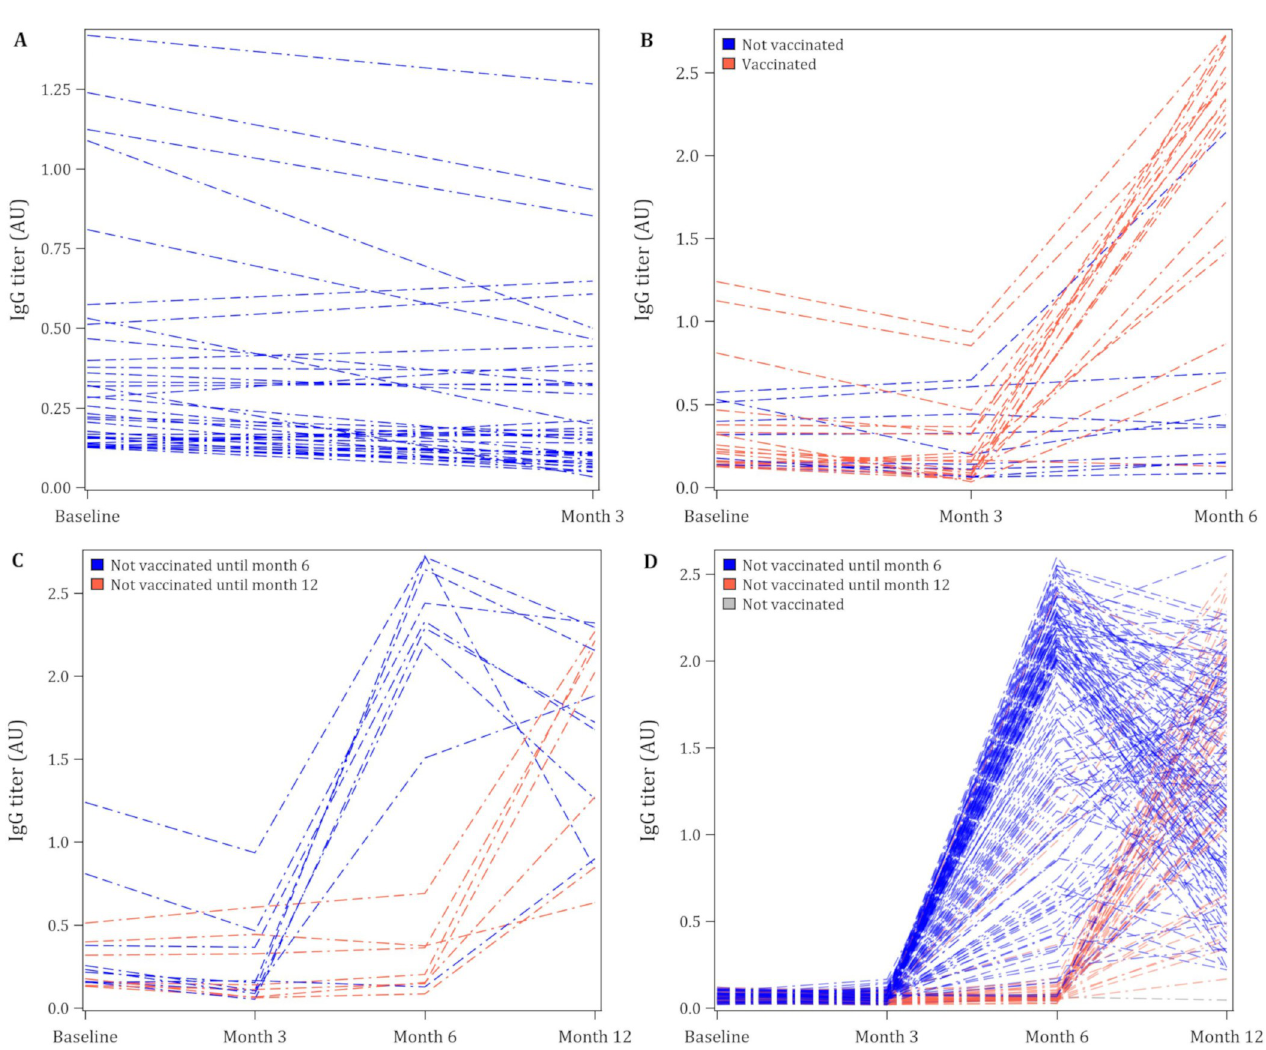
Fig 2. Spaghetti plots for participants positive IgG at baseline (A-C) and negative IgG at baseline (IgG) and subsequent follow-up levels. (A) Participants positive at baseline and had follow-up blood at month 3 (B) Participants positive at baseline and had follow-up bloods at months 3 and 6 (C) Participants positive at baseline and had follow-up bloods at months 3, 6 and 12 (D) Participants negative at baseline and had follow-up bloods at months 3, 6 and 12. Legend: AU = arbitrary units–the measurement is a subtraction of 570 nm background from 450 nm absorbance